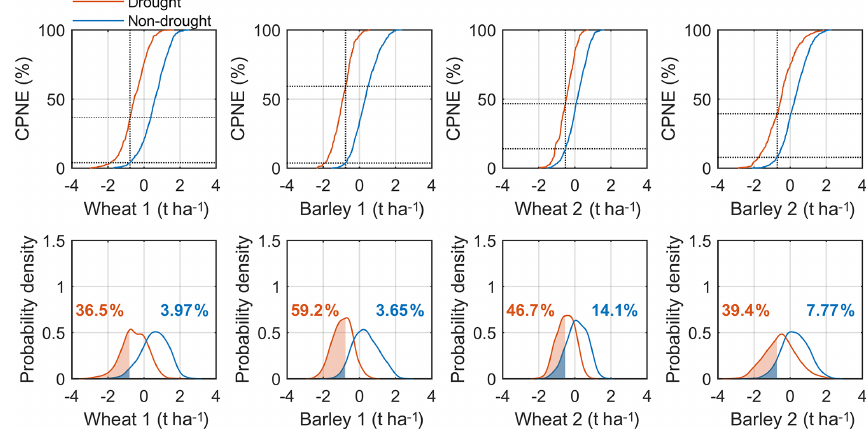
Figure 7. Conditional probability of non-exceedance (CPNE) function (%) based on the derived copula simulations (top row) and respective probability density estimates (bottom row) under drought (orange) and non-drought conditions (blue). In the bottom row, the orange and blue values indicate the probability of crop loss under the different climatic conditions, which is also indicated in the top row by the intersected dashed lines, which indicate the threshold of crop loss and respective CPNE